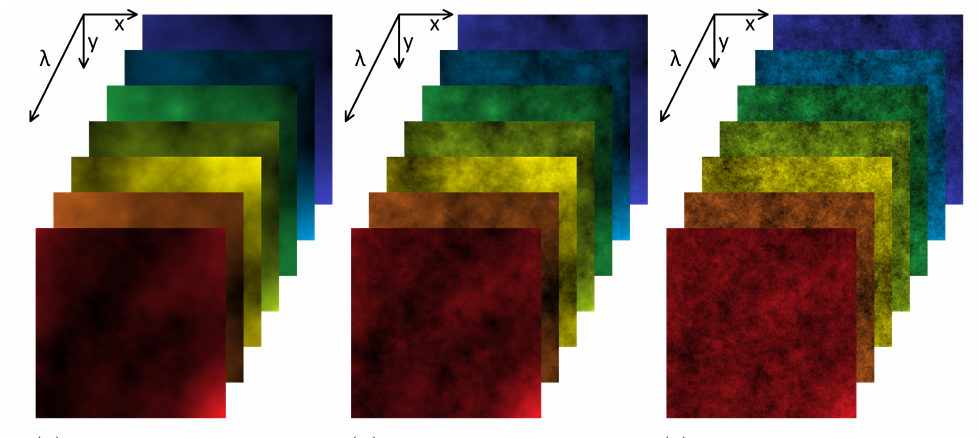
Figure 4. The multi-spectral fractal image data